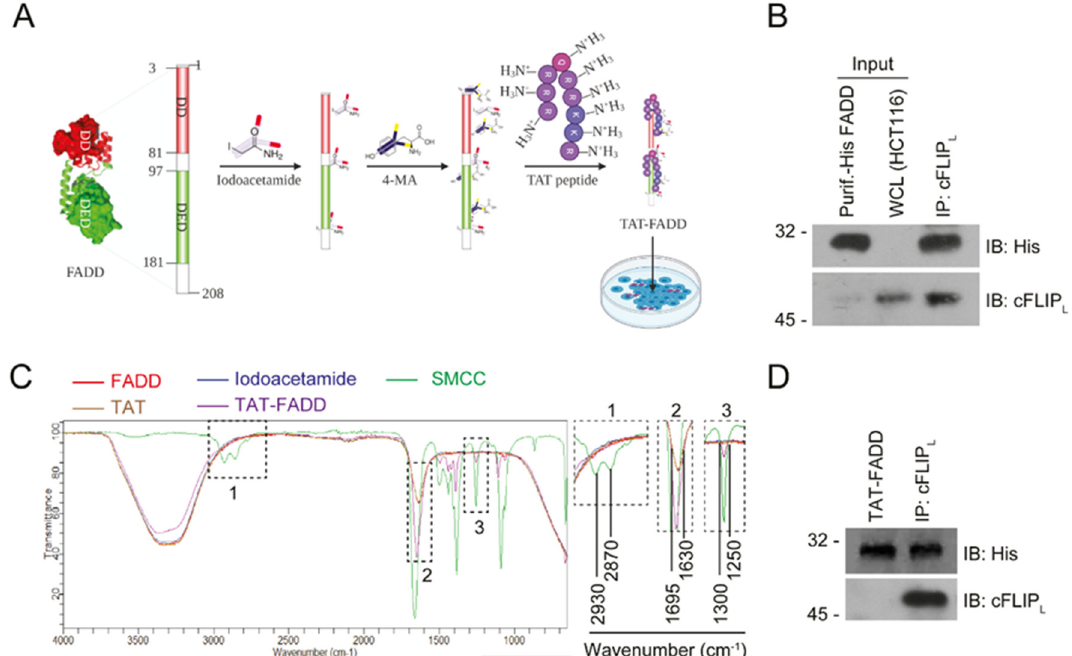
Figure 1. Human FADD protein conjugated with TAT peptide. ( A ) Schematic diagram showing the chemical conjugation of FADD protein (PDB ID-2GF5) with linker iodoacetamide and SMCC (4-MA) followed by TAT peptide. ( B ) In vitro protein interaction with purified His-tagged FADD and whole cell lysate (WCL) from HCT 116 cells, the immunoprecipitated (IP’ed) His-FADD interacts with binding partner cFLIP L protein, input lanes represent loading controls, as assessed by Western blot, molecular weight marker left to each blot. ( C ) The FT-IR analysis of TAT-FADD conjugate; inset box 1, 2, and 3 represent the corresponding peaks from the representative FT-IR spectrum. ( D ) In vitro protein interaction with His-taged TAT-FADD conjugate and whole cell lysate (WCL) from HCT 116 cells, the IP’ed His (TAT-FADD) interacts with cFLIP L protein, as assessed by Western blot, molecular weight marker left to each blot.